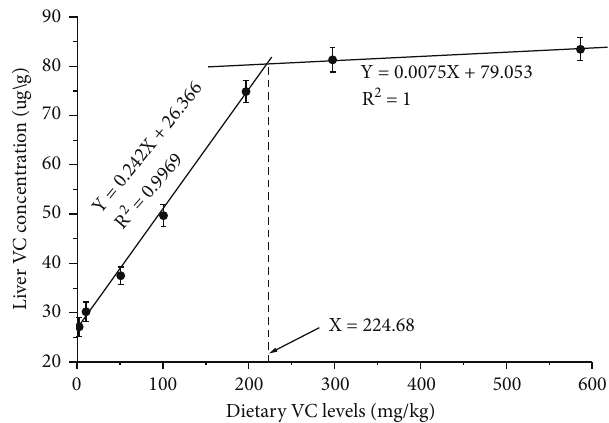
Figure 2: Broken-line analyses of liver vitamin C (VC) concentrations with dietary VC levels in coho salmon Oncorhynchus kisutch (Walbaum, 1792) postsmolts. The predicted dietary VC requirement based on liver VC concentration is